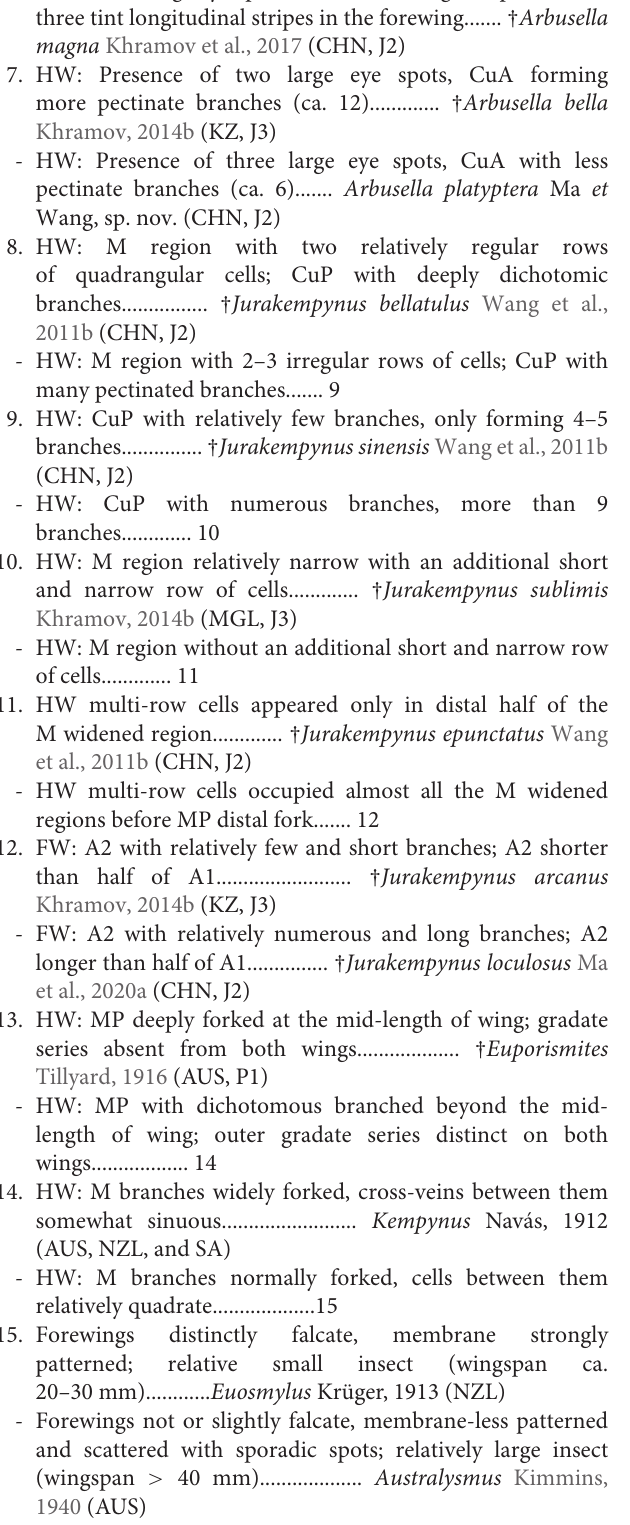
differences between the new specimen and the known